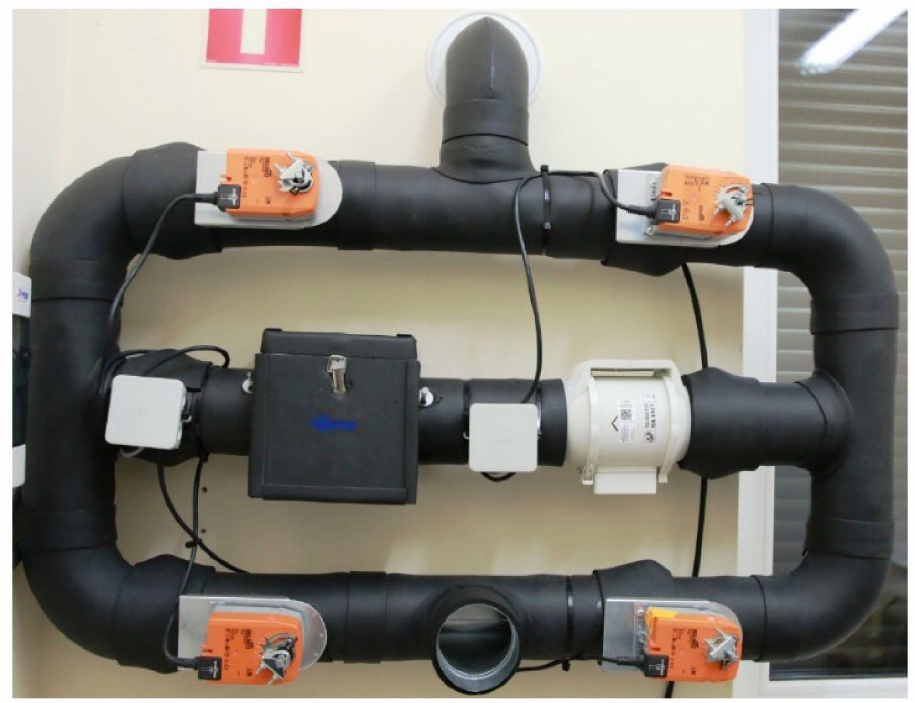
Figure 11. Façade ventilation unit analyzed in [67].